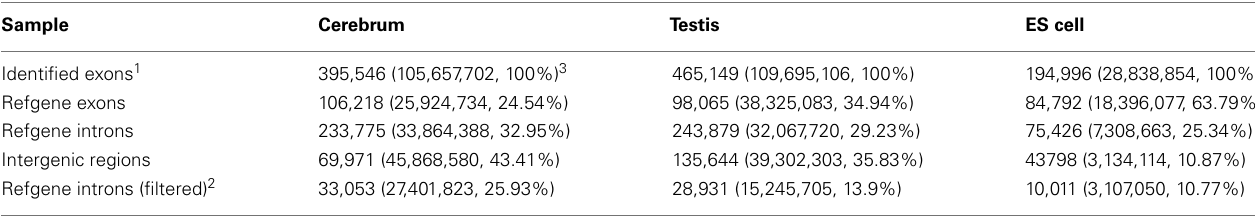
Table 1 | Summary of novel exons identified in our